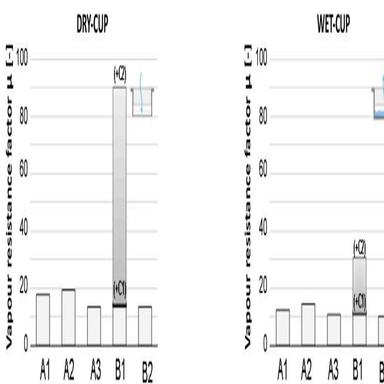
Resistance to water vapour diffusion, experimental results.